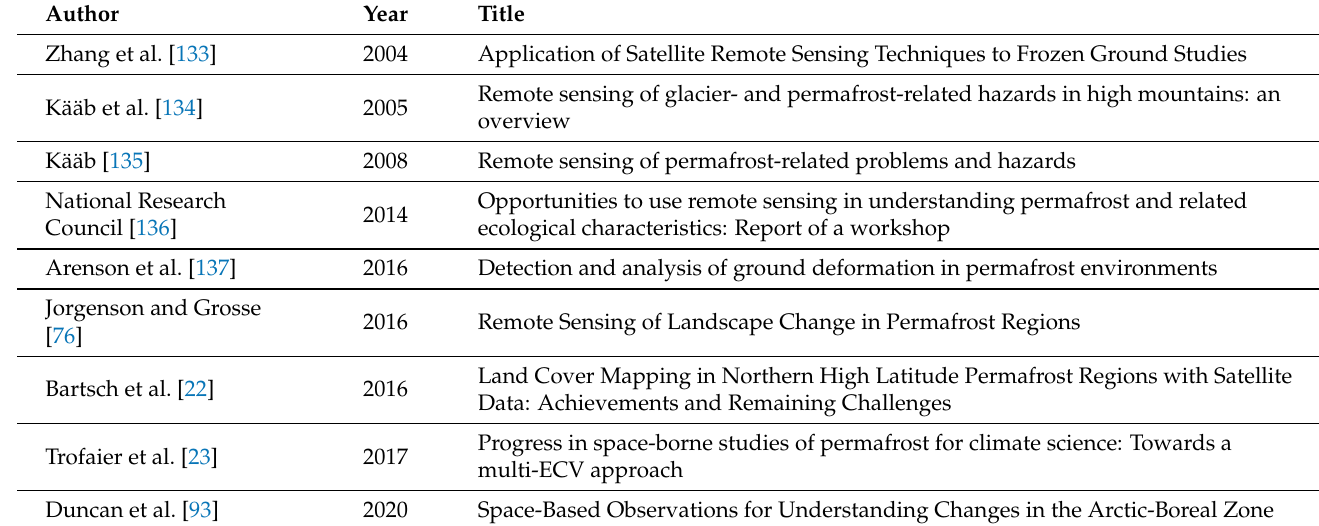
Table 2. Some remote sensing of permafrost related review articles during the last 20